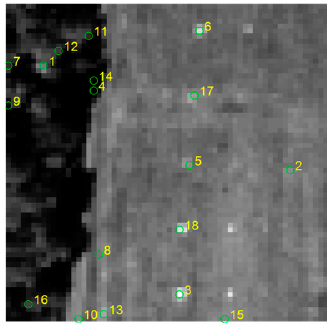
Figure 3. The 18 target pixels found by automatic target generation process (ATGP)